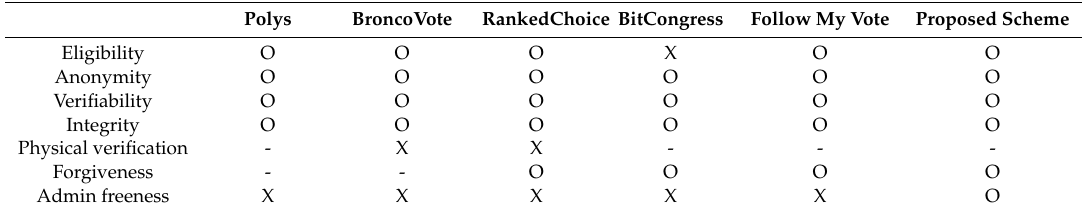
Table 6. Comparison of the previous e-voting protocols and our scheme. Polys BroncoVote RankedChoice BitCongress Follow My Vote Proposed Scheme